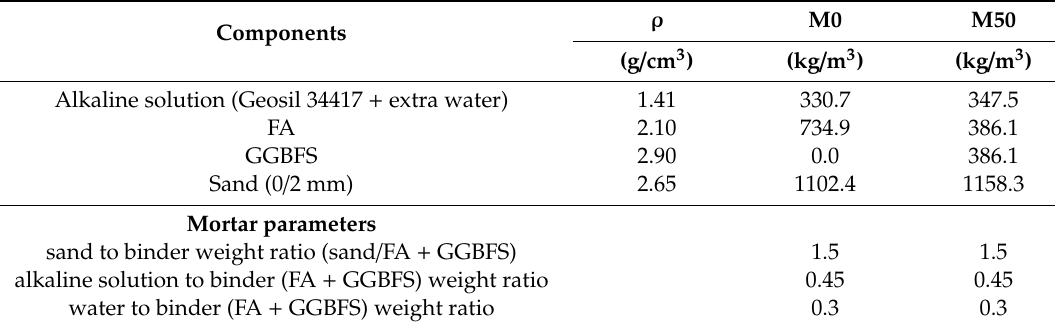
Table 3. Geopolymer mix compositions and basic mortar